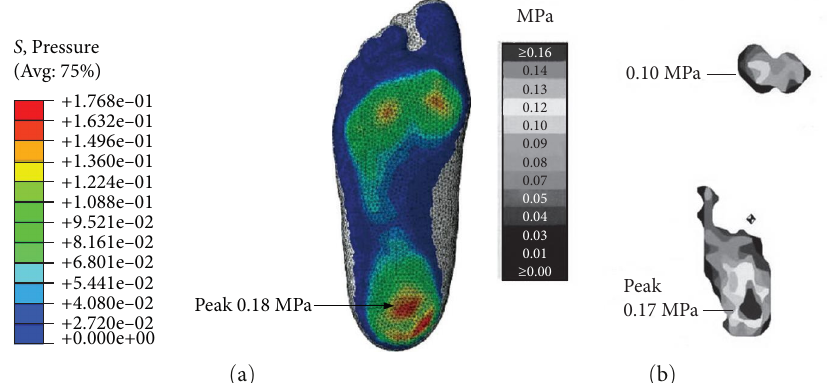
F IGURE 4: Comparison of (a) predicted plantar pressure in this study and (b) experimental plantar pressure tested by Yu et al. [24] under balanced standing.